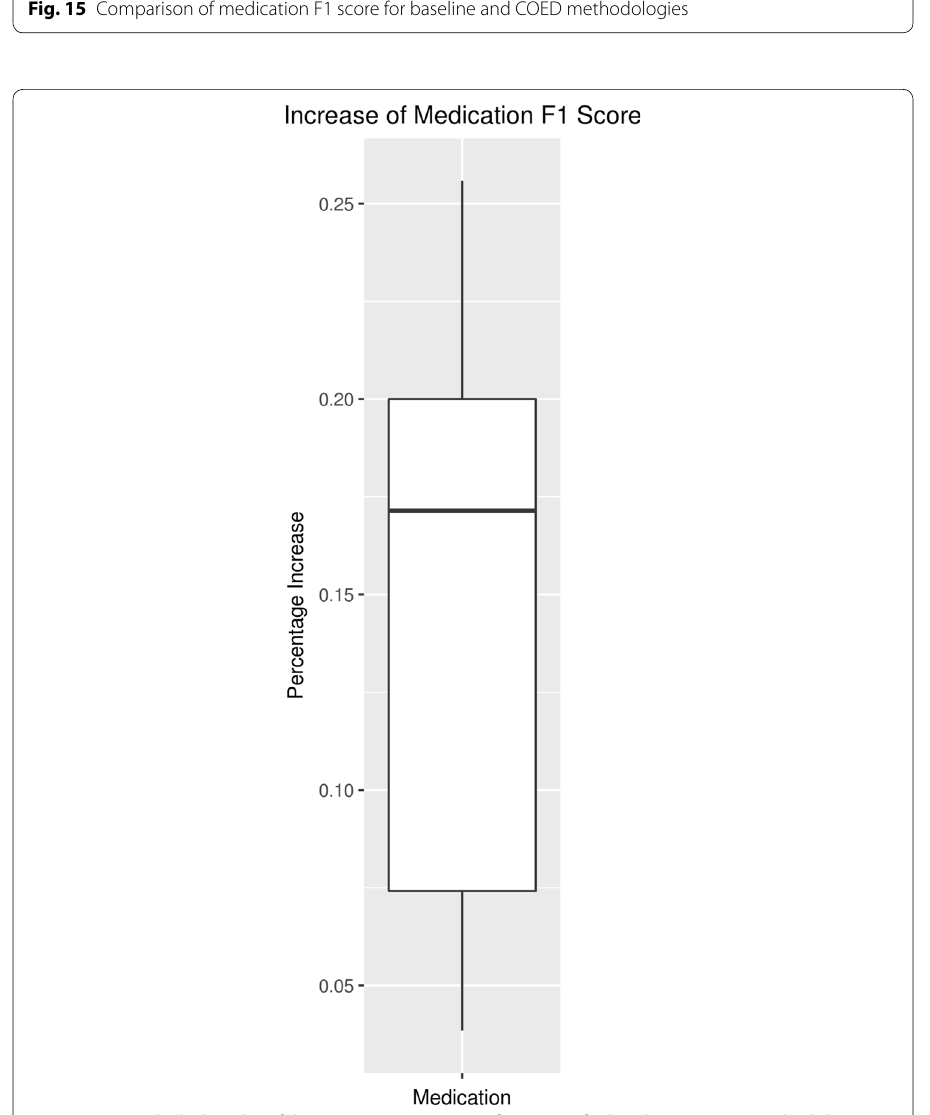
Fig. 16 Box and whisker plot of the percentage increase of F1 scores for baseline vs COED methodologies. Median percentage increase for medication F1 score is